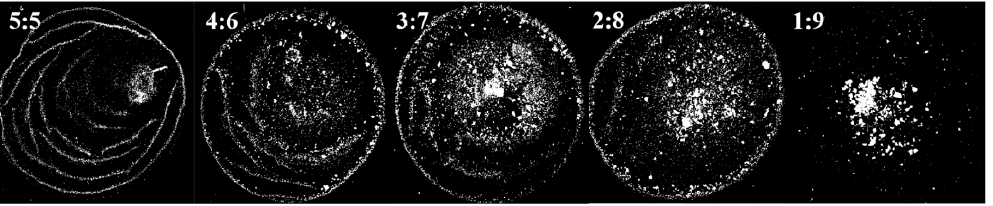
Figure 3. The morphologies of films prepared with different QD inks. The volume ratios of toluene to n-octane in the inks are 5:5, 4:6, 3:7, 2:8, and 1:9.